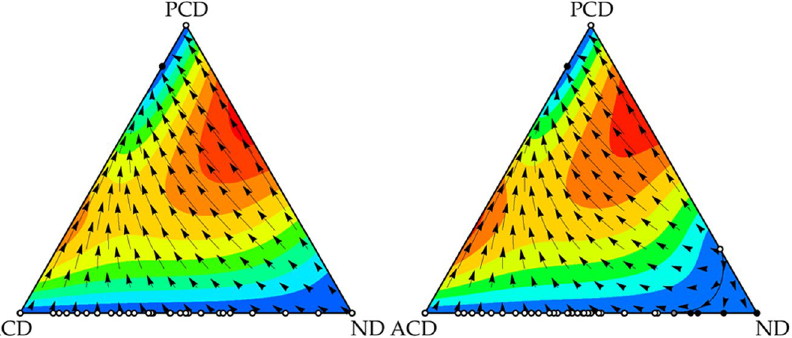
Figure 3. Pure defection is stable in PC games but not in RC games. A mixed state between cooperative proposers and acceptors is stable in both scenarios. Replicator dynamics for a subset of strategies in one-shot games. Replicator dynamics for an infinite population with ( P , C , D ), ( A , C , D ), and ( N , D ) strategies for RC (left) and PC (right) games. Small filled (empty) circles represent stable (unstable) rest points. We assumed  = 0.25 and δ = 4. Several filled (empty) circles along the ACD-ND axis reveal that the whole interval is stable (unstable) in the axis; the grey filled circle represents the change of stability in the axis for the PC game. Regions where the dynamics lead to a mixed state of ( A , C , D ) with ( P , C , D ) or ( N , D ) in the PC game are separated by a black curve. Figures obtained with Dynamo 58 .